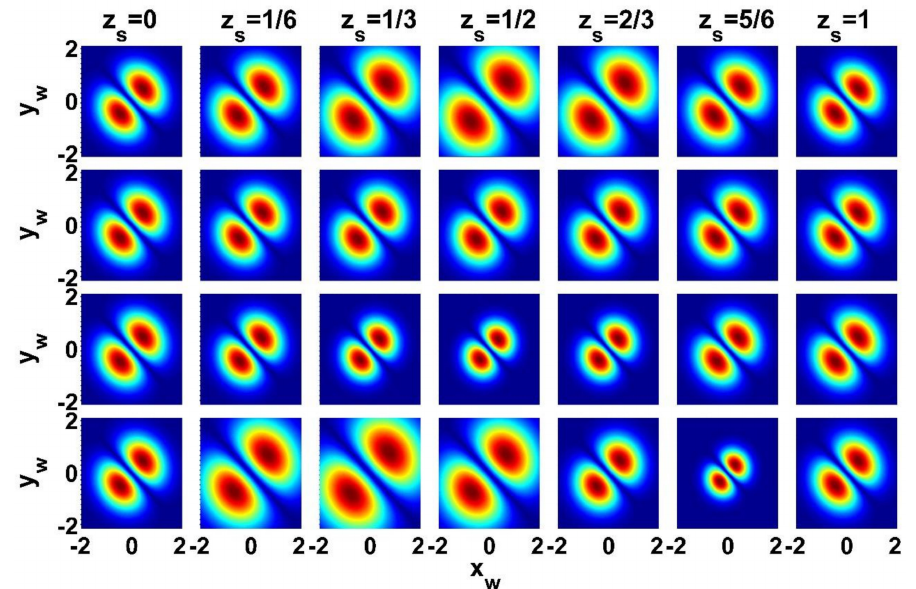
√ 2 z R ; √ 2 and Row 4: R 0x = R 0y = z R